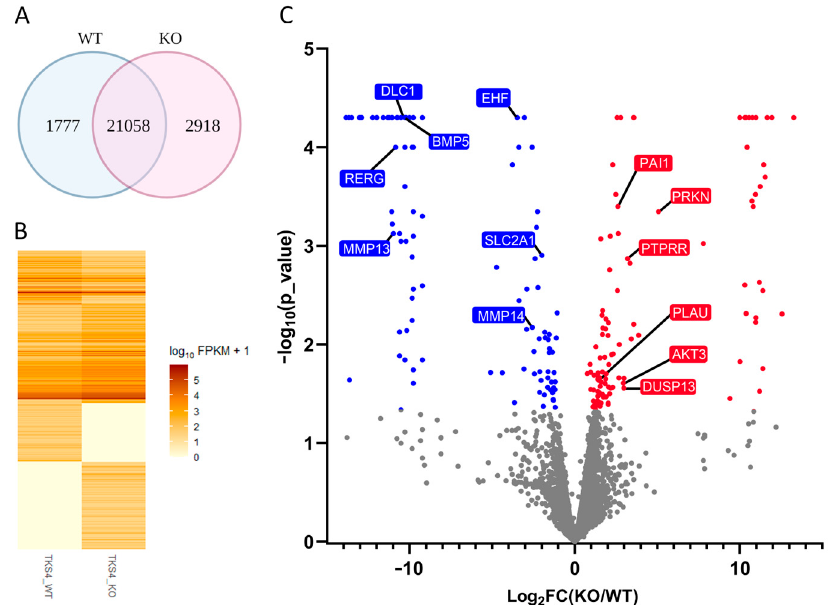
Figure 2. Changes in gene expression in Tks4 KO cells. ( A ) Venn diagram of the annotated genes expressed in WT and Tks4 KO cells. ( B ) Heat map of the mRNA expression levels in the Tks4 KO and the wild-type HCT116 cells. Each band corresponds to a specific gene. Darker colors represent higher expression of the specific gene. ( C ) Volcano plot of the differentially expressed mRNAs in the Tks4 KO cells. Each dot represents a specific gene. Gray: non-significant changes, red: upregulation, blue: downregulation.